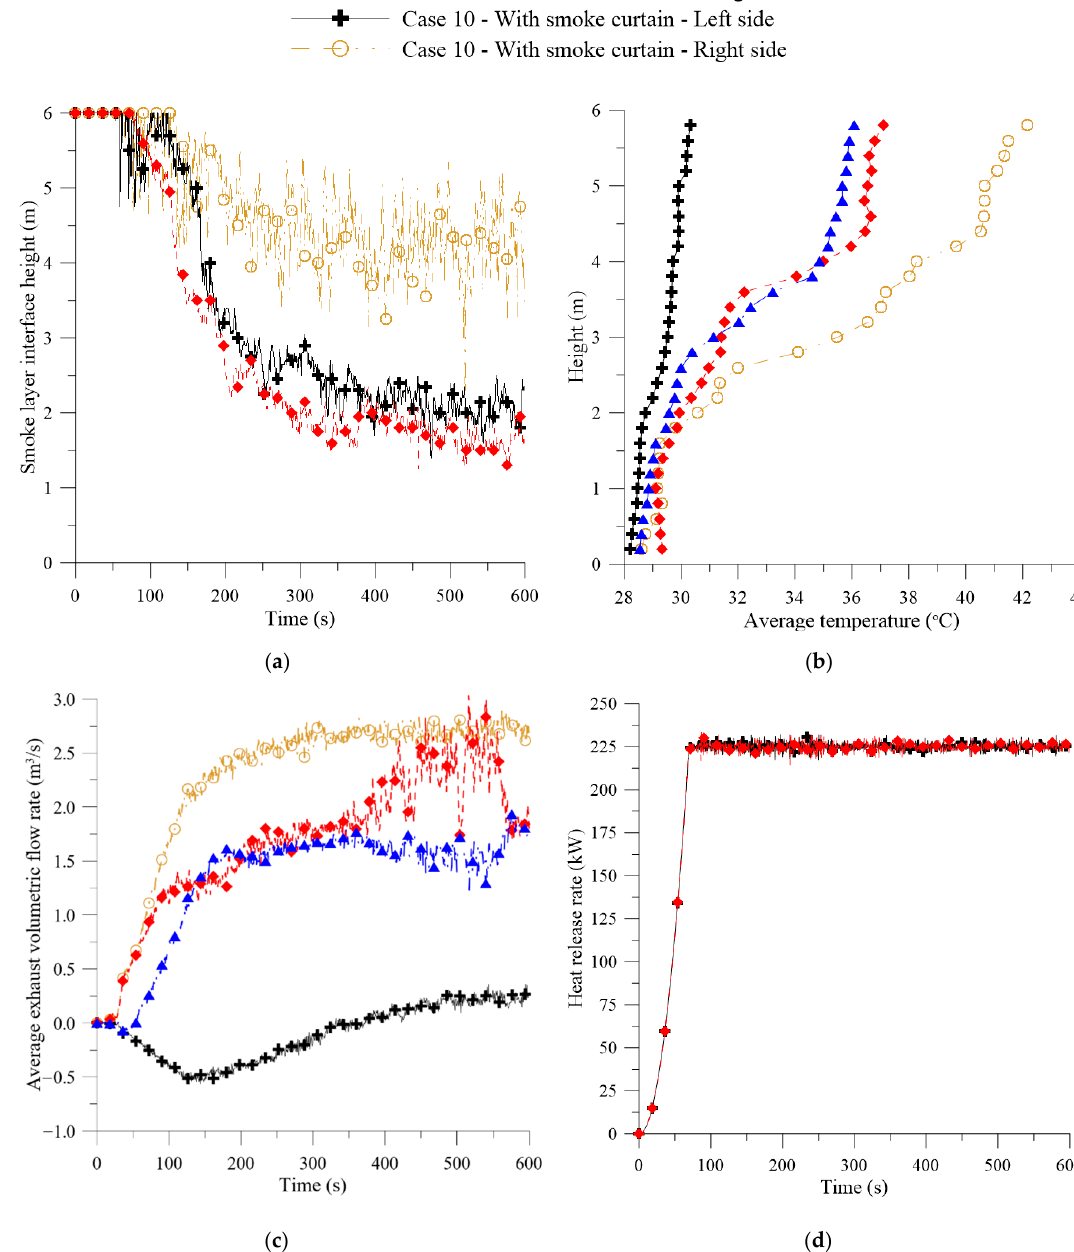
Figure 13. Influence of the smoke curtain in the ( a ) smoke layer vertical displacement; ( b ) average temperature profile at t = 600 s; ( c ) average exhaust volumetric flow rate and ( d ) HRR (compartments with natural exhaust areas of 9.00 m 2 , open windows and HRR = 225 kW).